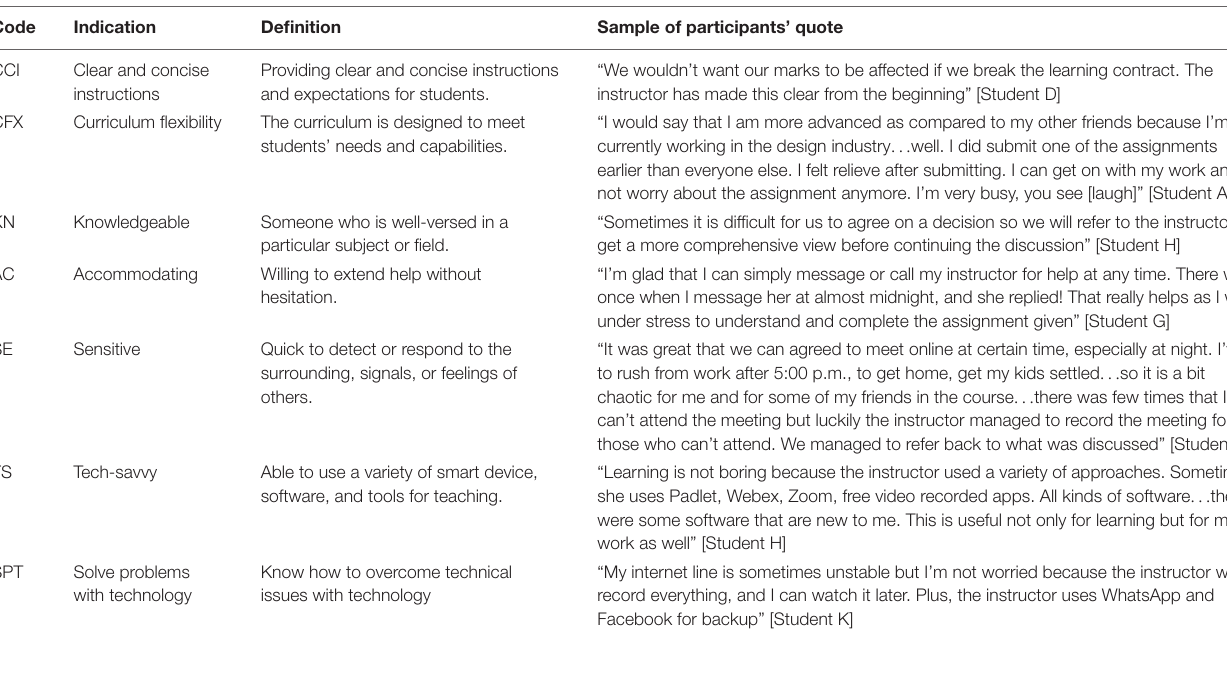
TABLE 1 | Codes and indications from semi-structured